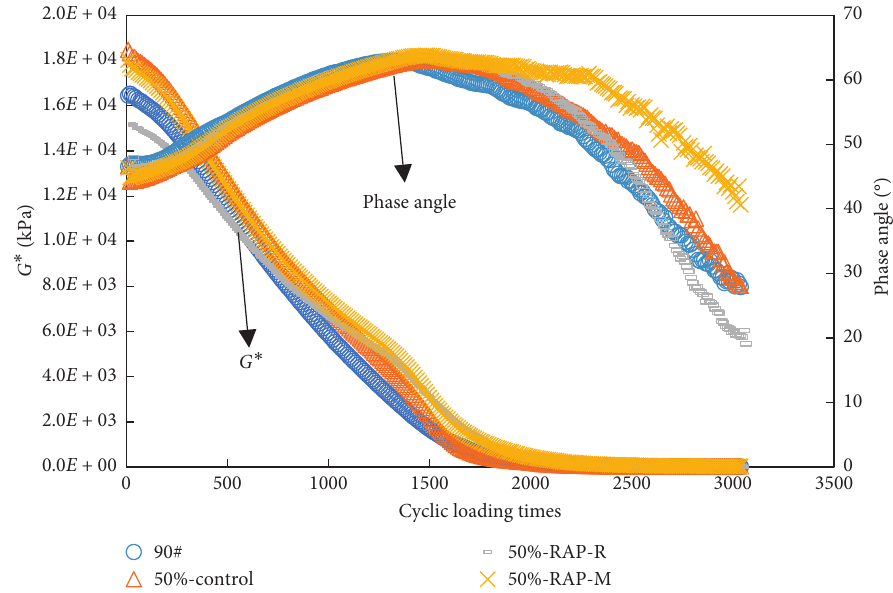
Figure 24: Relationship between complex shear modulus or phase angles and cyclic loading times.